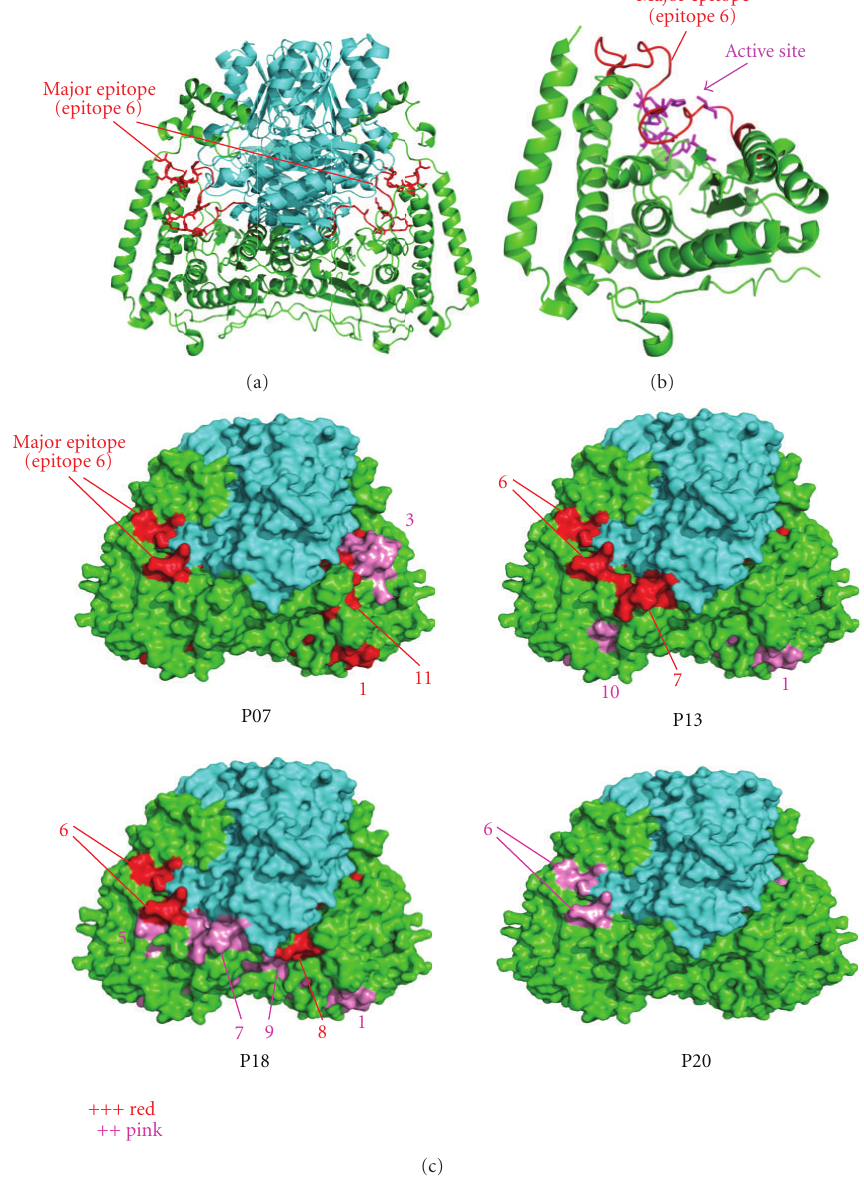
Figure 3: Three-dimensional mapping of the epitopes of BCOADC-E1 α . (a) Structural visualization of the major determinant (epitope 6) of BCOADC-E1 α . A three-dimensional structure of the E1 α 2 β 2 heterotetramer [21] is shown with the E1 α subunit in green and the E1 β subunit in cyan. The major determinant of E1 α is shown in red, with stick representations of the side chains of amino acids 137–142 and 153–156. (b) The major determinant overlaps with the active center pocket of E1 α [21]. The major determinant (epitope 6, aa 134–168) is shown in red, while the residues in the active site are shown in magenta with stick representation. (c) Surface representations of the epitopes of E1 α . The epitopes on the molecular surface of E1 α are drawn with the epitope numbers. The strengths of the antibody reactivities are indicated in red and pink, which correspond to +++ and ++ in Table 3,